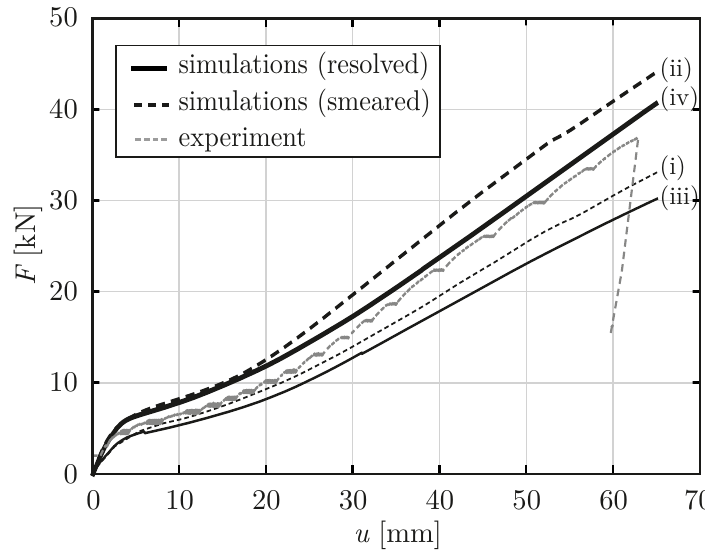
Figure 19. Simulated load–deflections curves in comparison with the test